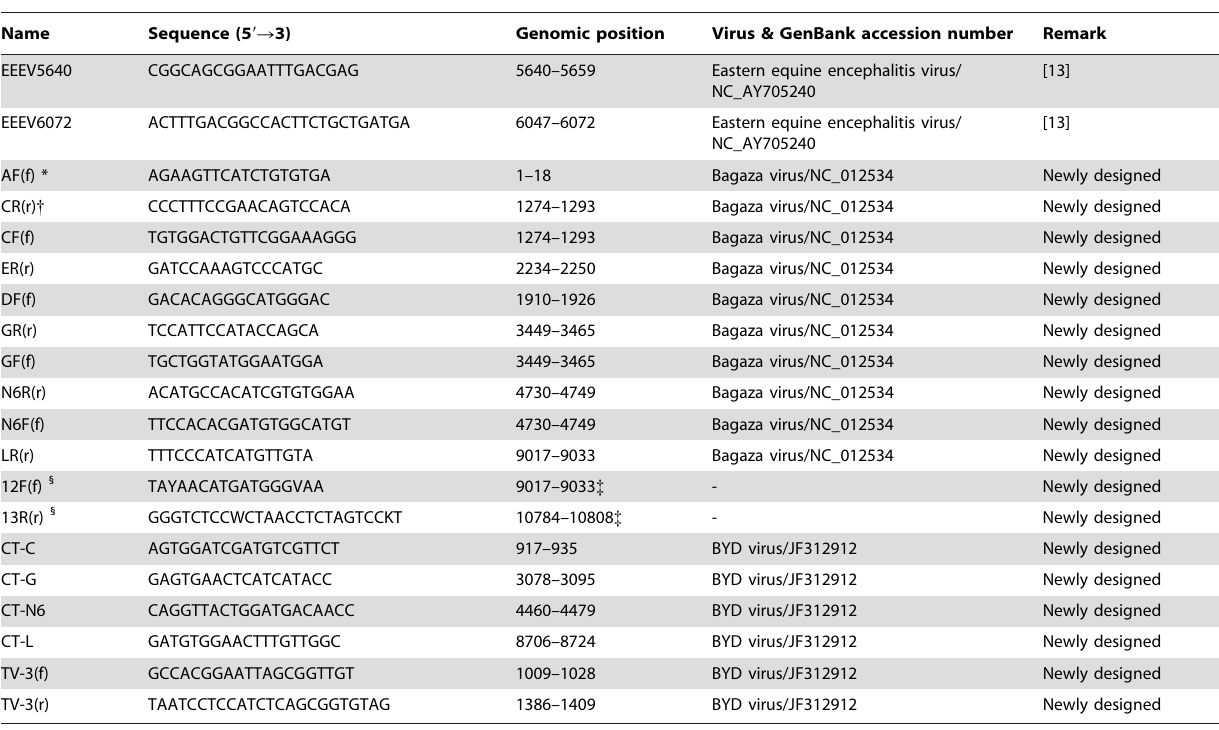
Table 2. Primers and viruses referred to in this